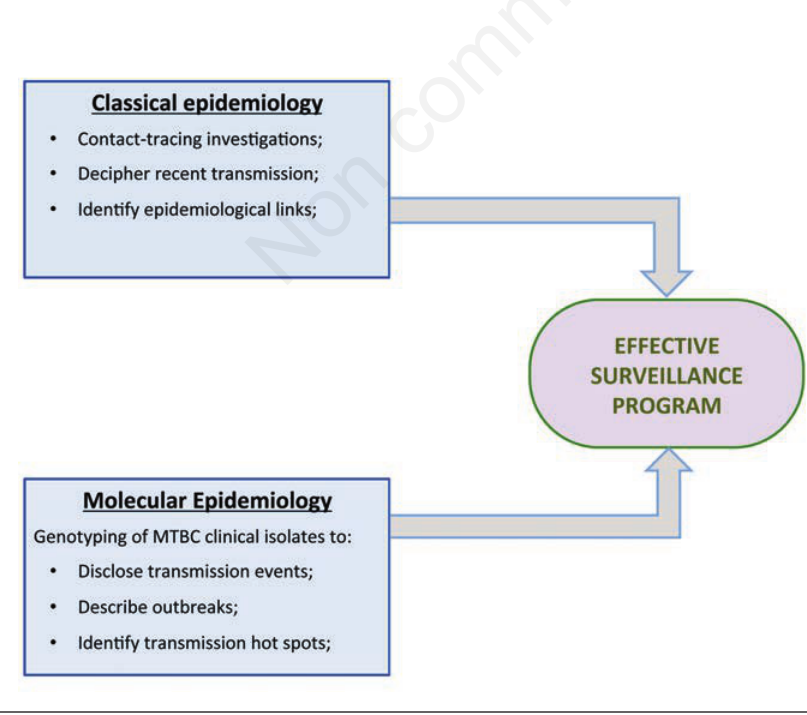
Figure 2. A concerted use of classical and molecular epidemiology tools is required to control tuberculosis at local and regional